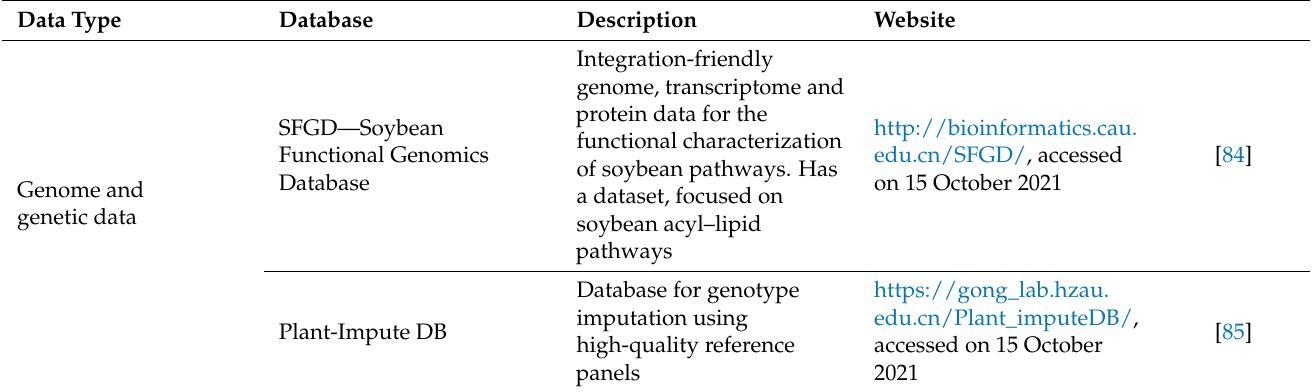
Table 1. Available database resources for soybean genome investigation and computational